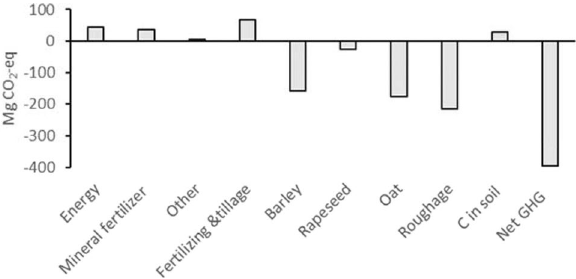
Fig. 3 Greenhouse gas (GHG) emissions from the arable farm, cal- culated using carbon capture-life cycle assessment (CC-LCA)